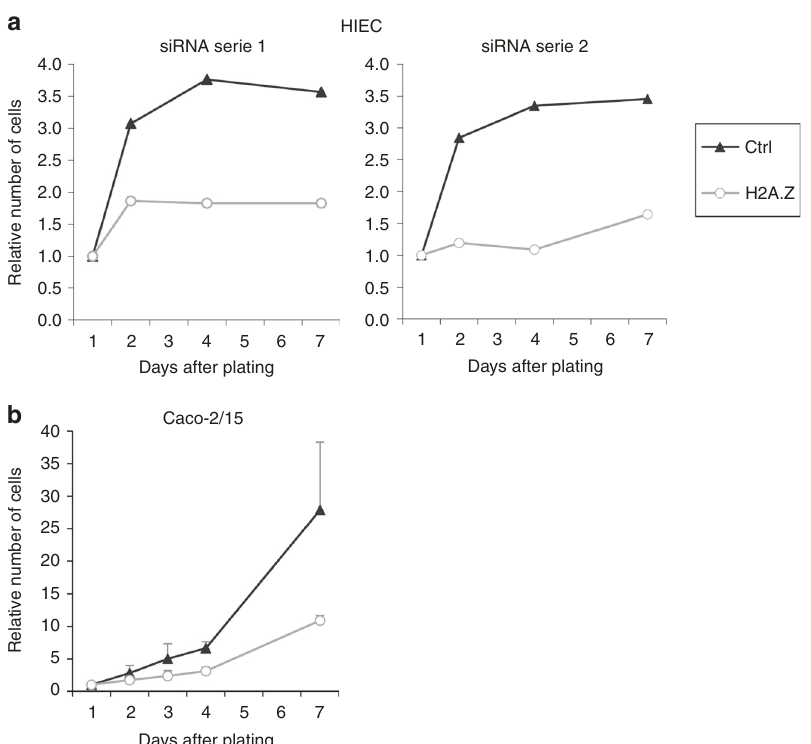
Fig. 1 H2A.Z-dependent regulation of intestinal epithelial cell proliferation. a HIEC cells were transfected using siRNAs targeting H2A.Z mRNA or control. Two different series of siRNAs were used. Cell number was measured and represented relative to 1 for day 1 after transfection and plating. One representative experiment out of two is shown for each serie. b Caco-2/15 cells were transfected using siRNAs control or directed against H2A.Z and the cell number was measured and represented relative to 1 for day 1 after transfection and plating. The mean and standard deviation are shown ( n = 3 independent